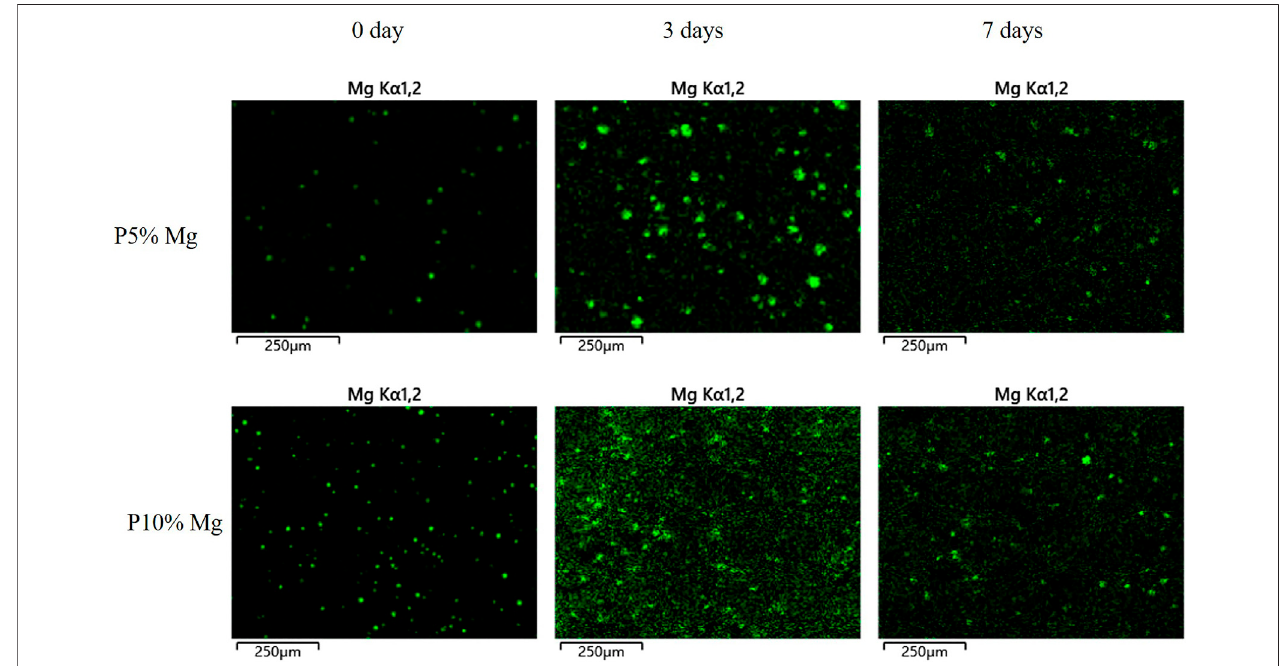
FIGURE 2 | EDS-mapping analysis of the surfaces of P5% Mg and P10% Mg for 0, 3, and 7 days.